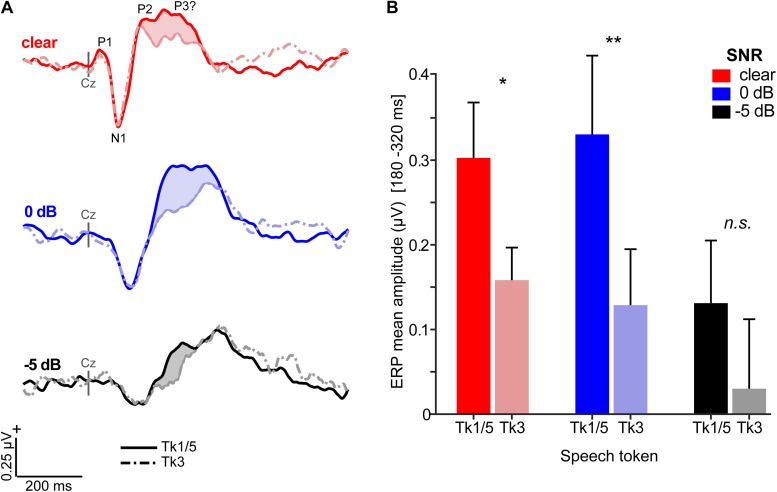
Categorical neural organization limits the degradative effects of noise on cortical speech processing. (A) Scalp auditory ERP waveforms (Cz electrode). Stronger responses are observed for phonetic exemplar vs. ambiguous speech tokens [i.e., mean(Tk1, Tk5) > Tk3; shaded regions] but this effect varies with SNR. (B) Mean ERP amplitude (180–320 ms window) is modulated by SNR and phonetic status. Categorical neural encoding (Tk1/5 > Tk3) is observed for all but the noisiest listening condition. errorbars = ± s.e.m. *p < 0.05; ** p < 0.01.